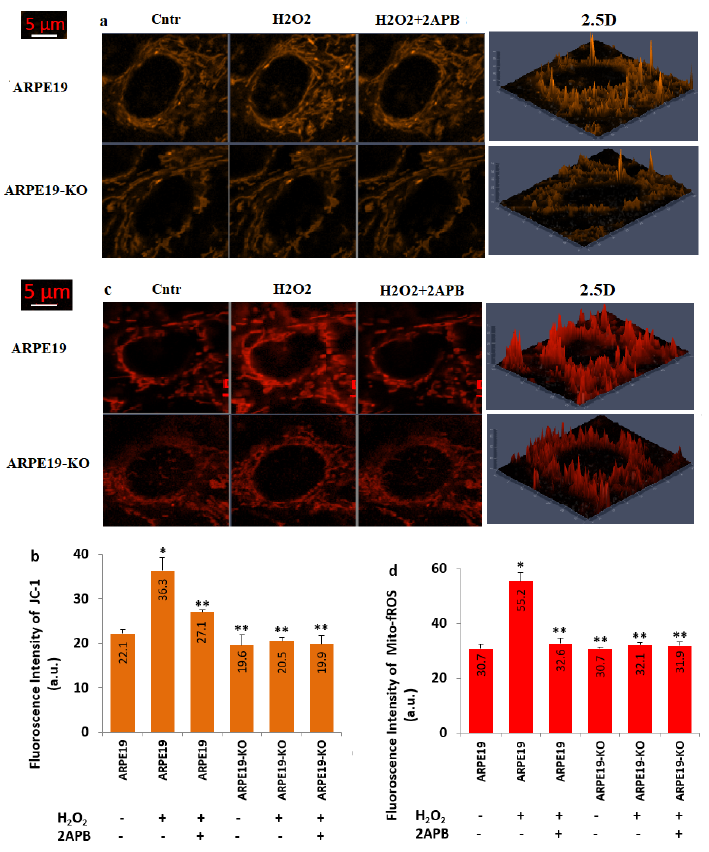
Figure 7. The levels of Mito-Dep (JC-1) and mitochondrial fROS (Mito-fROS) were upregulated in the ARPE19, but not in the ARPE19-KO by the stimulation of H 2 O 2 . (N = 25–30 and mean ± SD). After staining the cells with JC-1 (5 µM) and MitoTracker Red CM-H2ros (1 µM) dyes, the images of JC-1 and Mito-fROS were captured in the LSM 800 with the 40 × 1.3 oil objective. ( a ). The images of JC-1. ( b ). The mean fluorescence intensities of the JC-1 as arbitrary unit (a.u). ( c ). The images of MitoTracker Red CM-H2ros. ( d ). The mean fluorescence intensities of the Mito-fROS. (* p ≤ 0.05 vs. ARPE19 group. ** p ≤ 0.05 vs. ARPE19 + H 2 O 2 group).